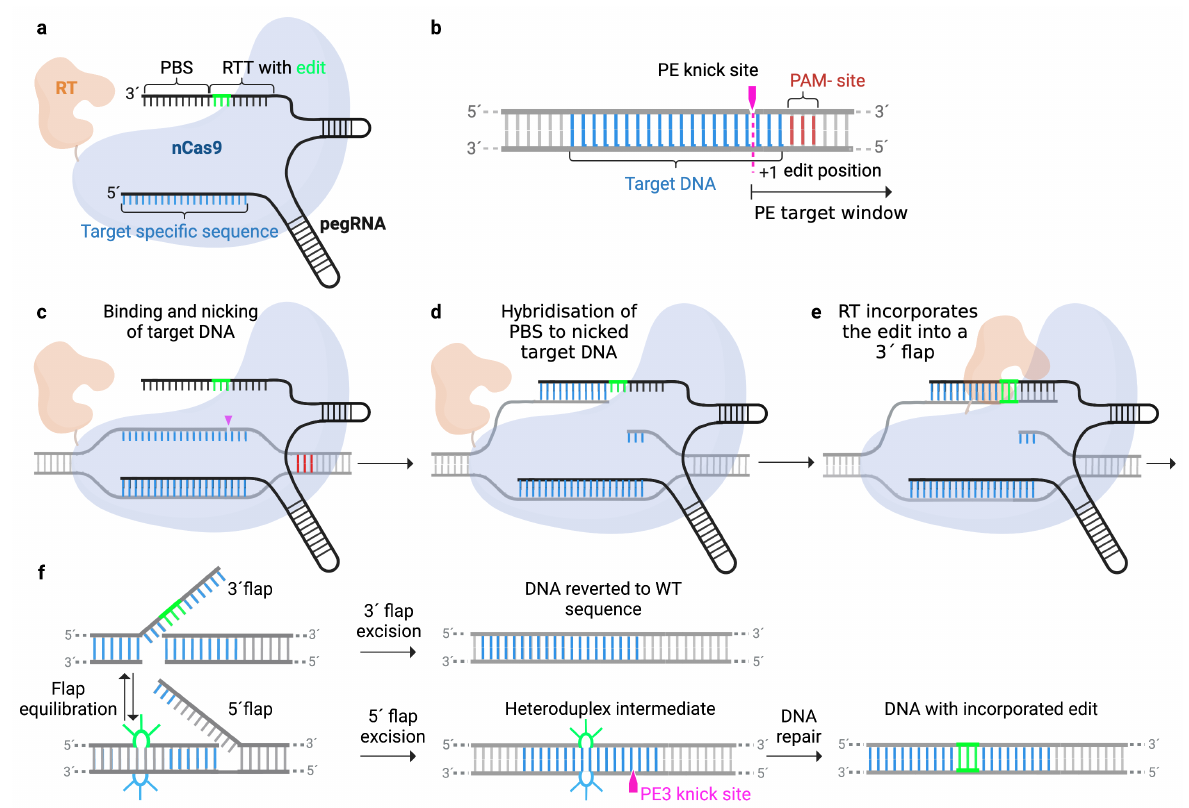
Figure 2. Graphical overview of the prime-editing technology. ( a ) The prime-editor complex consists of a H840A SpCas9 nickase (nCas9) fused to a reverse transcriptase (RT) and a prime editing guide RNA (pegRNA) containing the primer binding site (PBS) and the RT template (RTT) encoding for the desired edit (green). ( b ) Detailed presentation of the target DNA. ( c ) The PE complex binds to the target DNA and nicks the PAM-strand. ( d ) The PBS anneals to the nicked target DNA and ( e ) enables the RT to start reversed transcription using the RTT as a template. This induces a 3 ´ flap with the desired edit. ( f ) The 3 ´ flap equilibrates with the unedited 5 ´ flap. Excision of the 5 ´ flap by endonuclease produces a heteroduplex intermediate consisting of one DNA strand with the desired edit and the complementary strand without the edit. DNA repair of the unedited strand results in permanent incorporation of the desired edit on both DNA strands. Nicking of the unedited strand with a conventional sgRNA biases repair towards installation of the